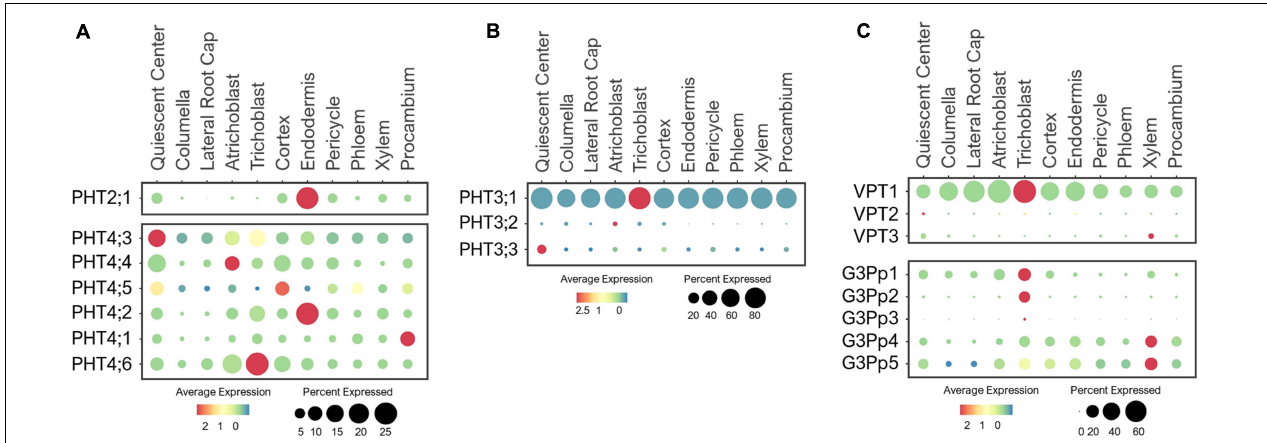
FIGURE 7 | Expression of the (A) PHT2/4, (B) PHT3 and (C) VPT and G3Pp transporters in Arabidopsis root single cells. In dot plots, the circle size represents the proportion (%) of cells expressing a given gene, and the color of scale bar represents the mean expression (natural log +1 pseudocount).